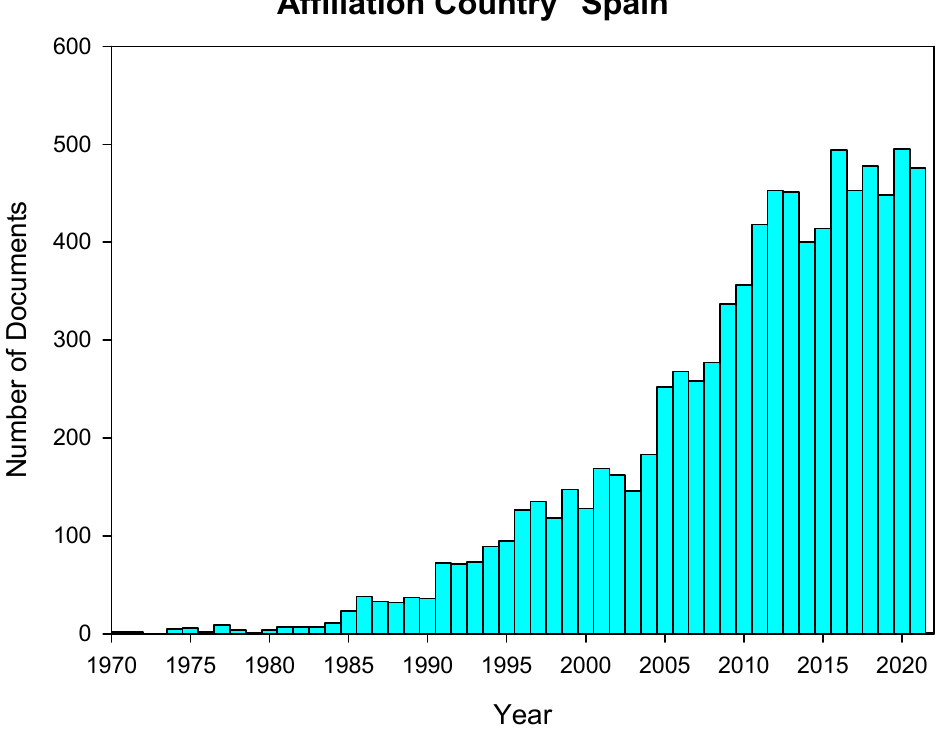
Figure 4. Spanish based publications in international journals from 1960. (Source: Scopus, Keyword “Membrane”).